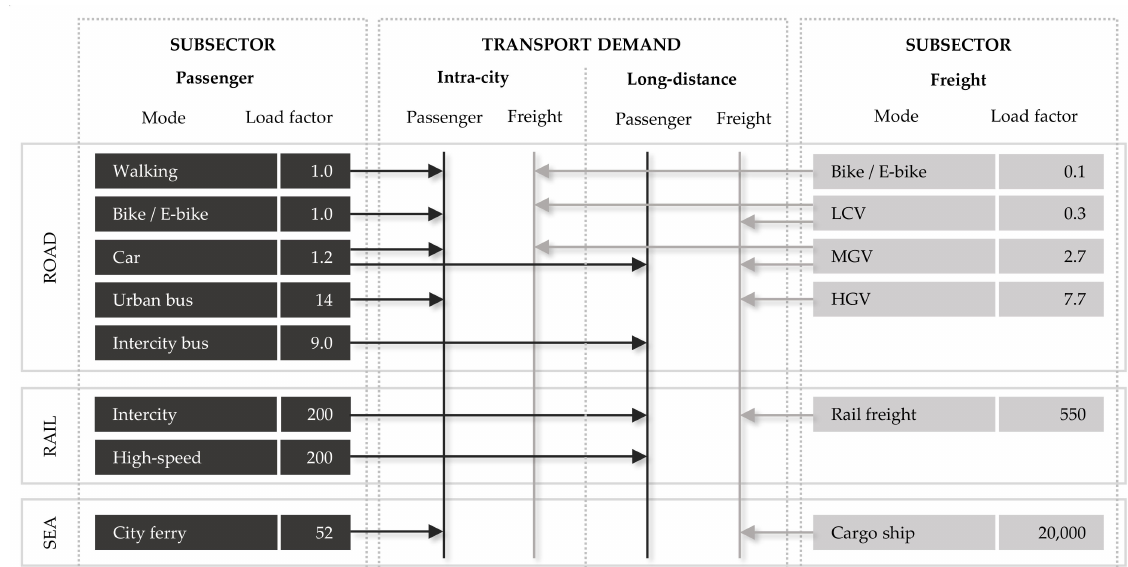
Figure 2. Transport sector representation used in the study, with load factors detailing the as assumed number of passengers or tons of goods for each mode of transportation. Note : LCV = light commercial vehicle (<3.5 t); MGV = medium-sized goods vehicle (3.5–18.0 t); HGV = heavy goods vehicle (>18.0 t).